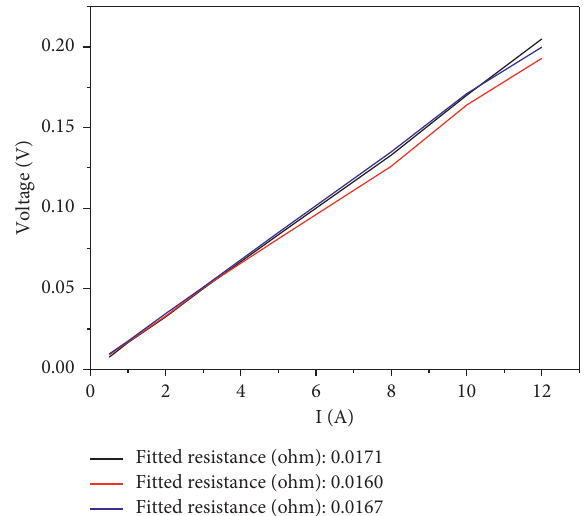
Figure 8: Relationship between voltage drop at both ends of the probe and current (perpendicular to the plane direction).